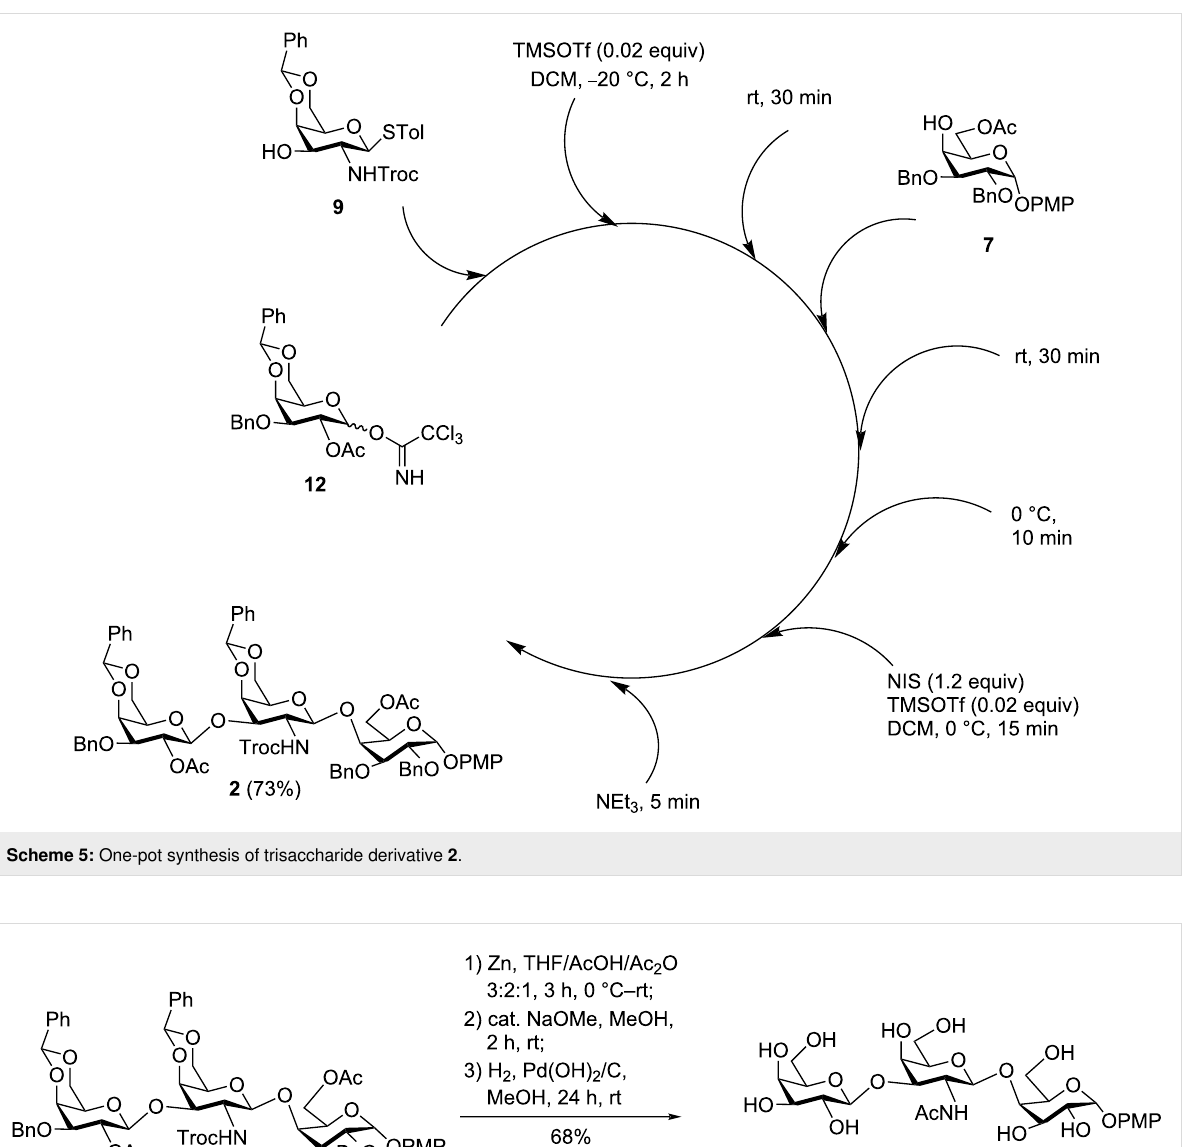
Scheme 6: Synthesis of trisaccharide derivative 1